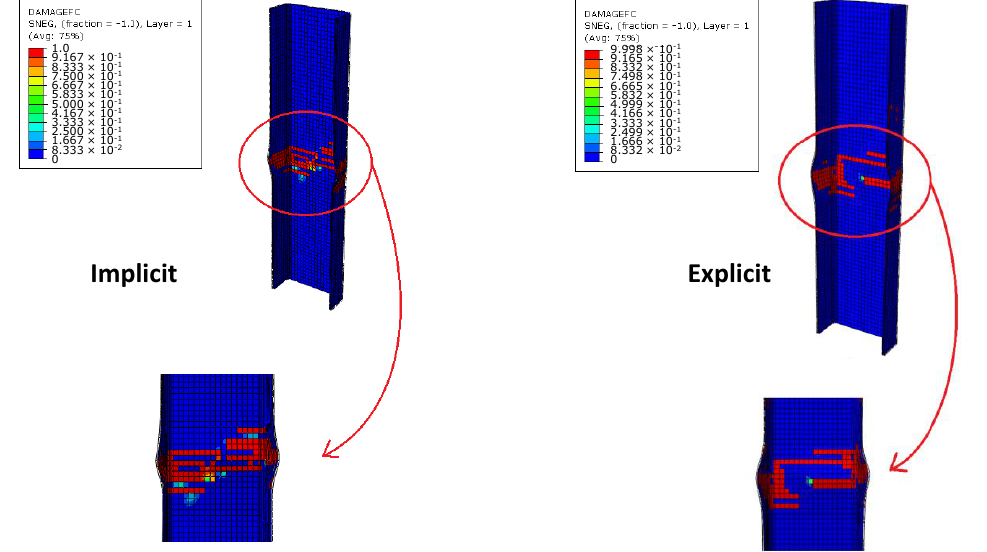
Figure 10. Implicit–explicit formulation comparisons: Failures. Table 4. Implicit–explicit formulation comparisons: Failure displacement and failure load.